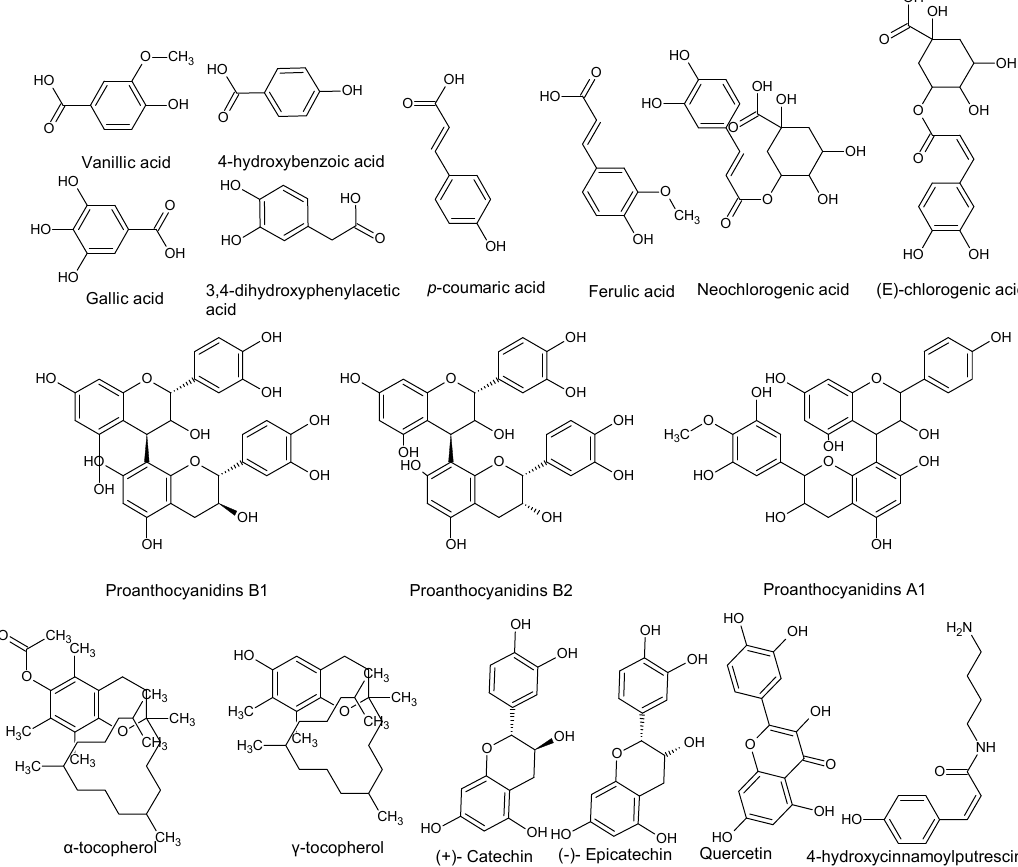
Figure 2. Phenolic compounds isolated from avocado.